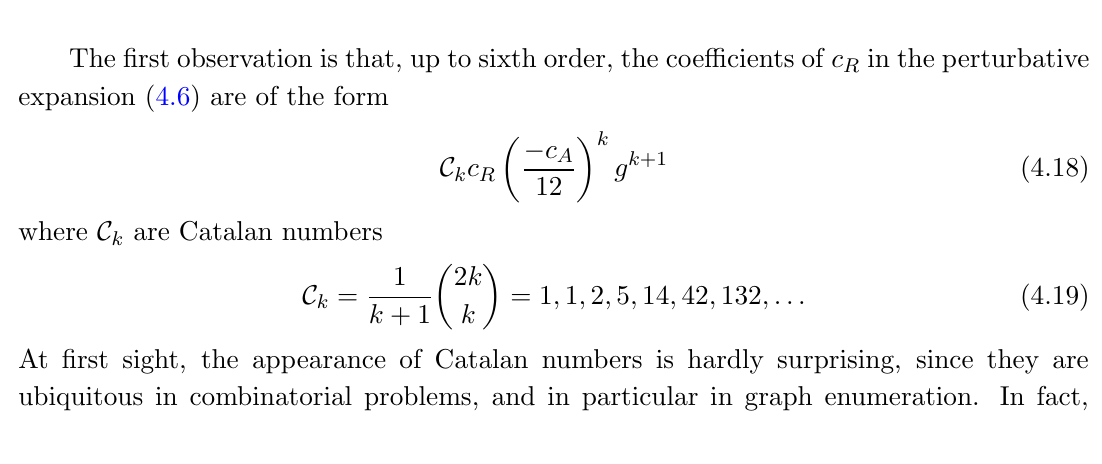
Figure 5. The (cid:12)rst column displays all the non-isomorphic intersection graphs, up to four loops (graphs with four dots). The middle column shows a representative of the connected chord diagrams that share the given graph. The last column displays the modi(cid:12)ed color factor that must be assigned to all diagrams with the same intersection